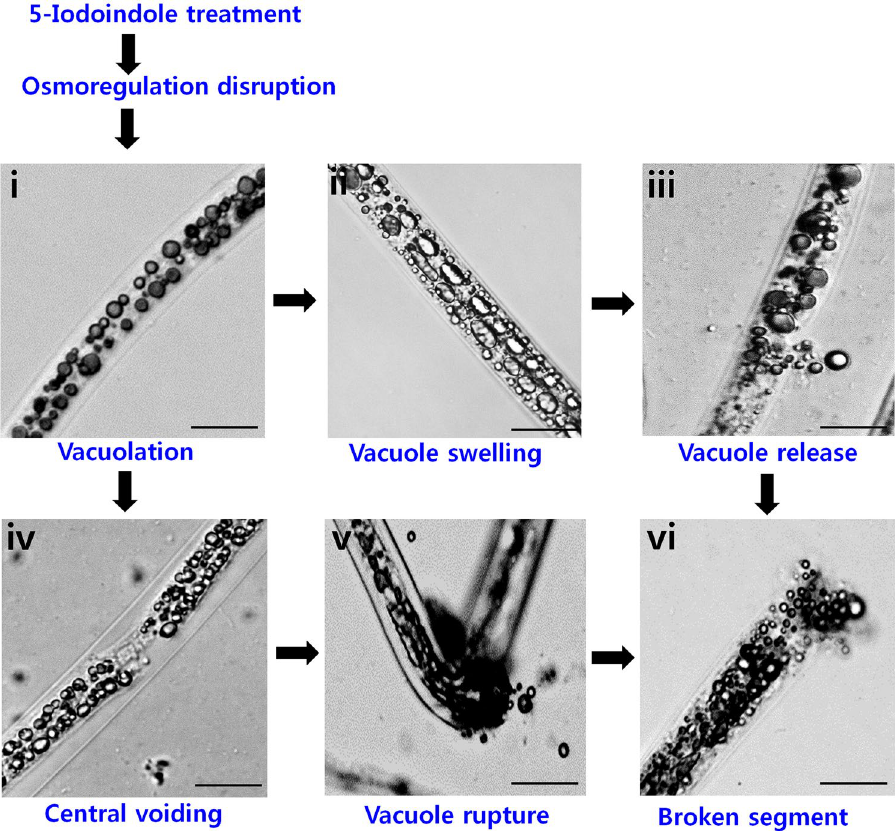
Figure 5. Proposed mechanism of vacuole formation and the sequence of events leading to nematode death. 5-Iodoindole treatment resulted in fluid accumulation and the disruption of osmoregulation, a process which triggers RCI. RCI resulted in ( i ) rapid vacuolation, ( ii ) vacuolar swelling, and ( iii ) vacuole release. In one model, we propose and show that ( iv ) vacuoles aggregated or align in opposite directions creating a large central void, which further ( v ) ruptured, and ( vi ) released the vacuoles to the external environment. Scale bars = 50 µ